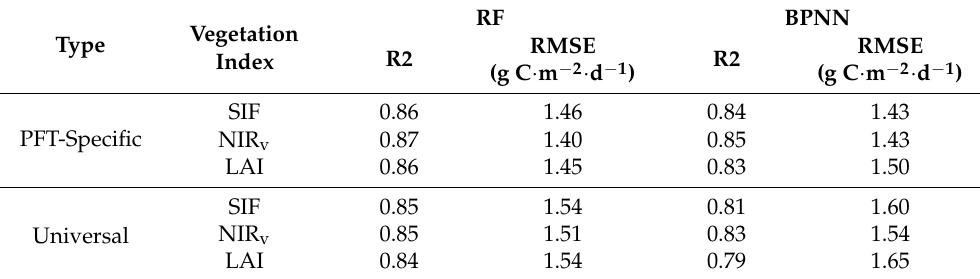
Table 2. Performance of optimal models for each vegetation index. Note that PFT was used as a predictor in the PFT-specific models, while it was not included in the universal